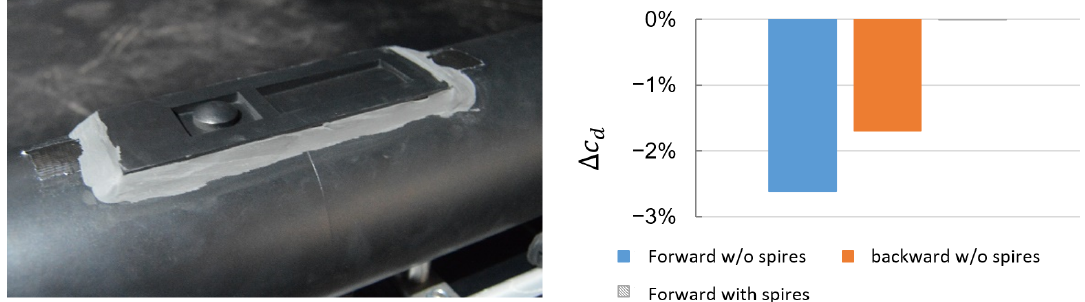
Figure 8. Fairing of roof platform. ( Left ): modeled fairing with clay; ( Right ): obtained drag